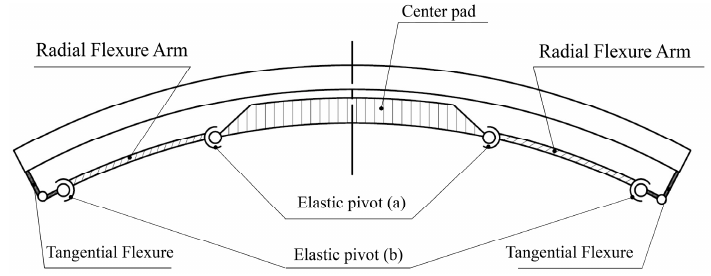
Figure 10. Multi-link mechanism of MF.